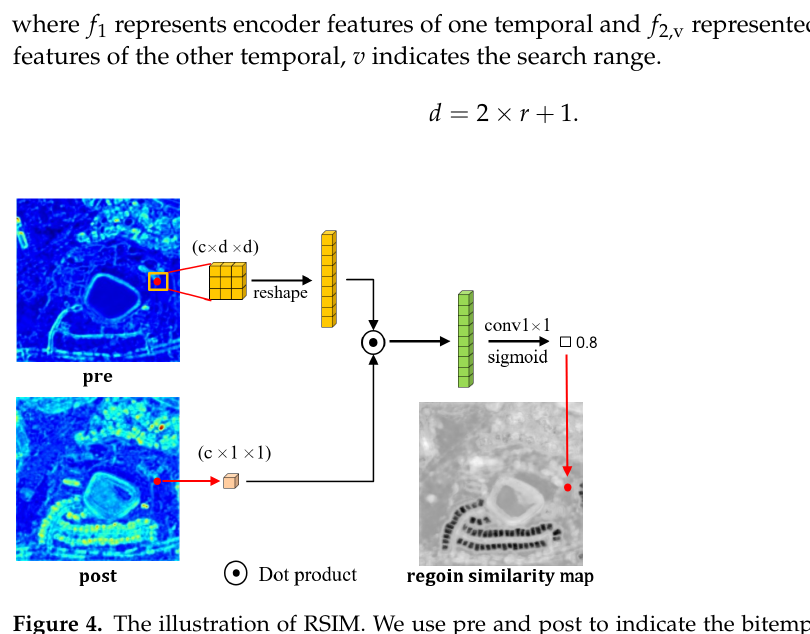
Figure 4. The illustration of RSIM. We use pre and post to indicate the bitemporal features. The symbol c denotes the channel of the features, and d indicates the diameter of the searching range.